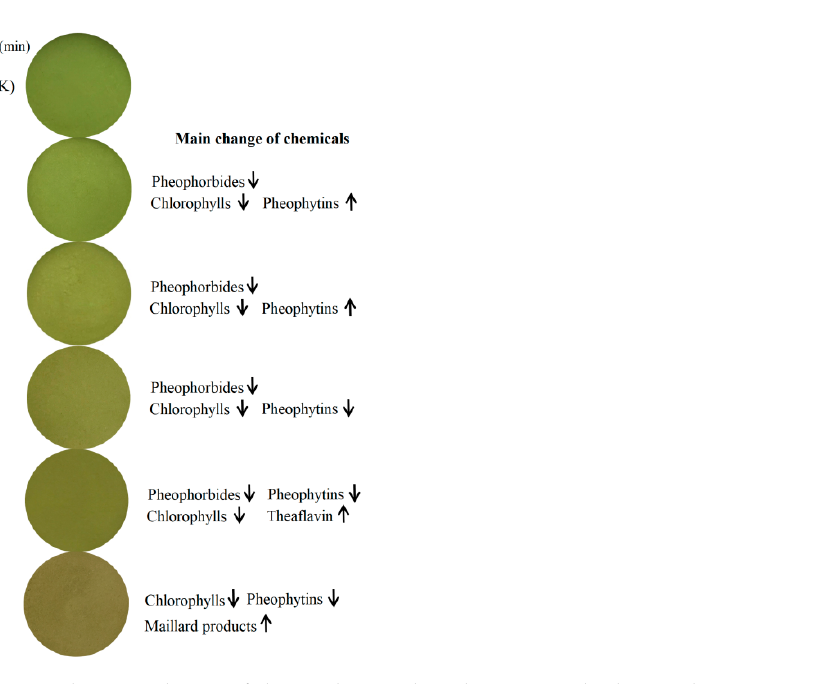
Figure 4. The main change of chemicals contributed to green color loss under green tea powder after microwave radiation of various times.